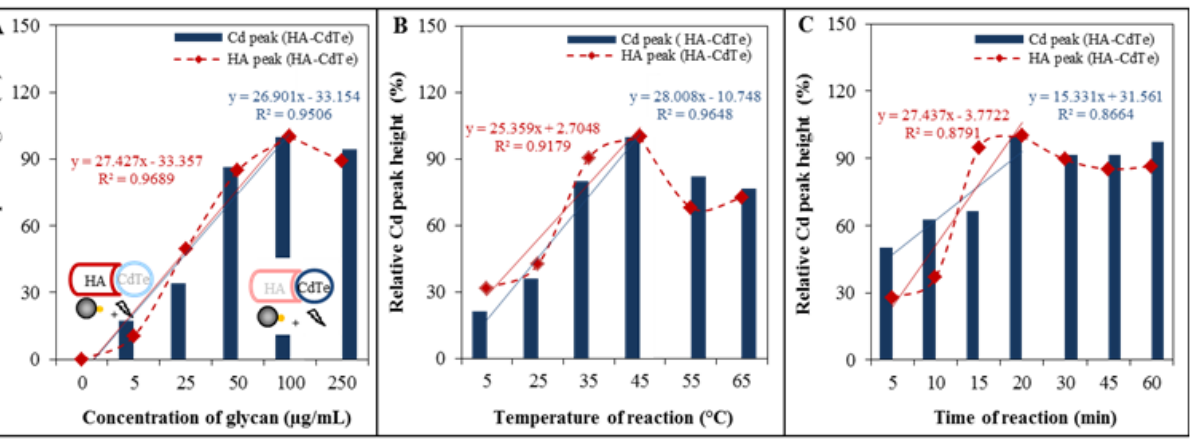
Figure 4. Optimization of isolation procedure. ( A ) Dependence of relative Cd peak height (related to the maximum value) on optimized condition (blue column). Dependence of relative HA peak height (related to the maximum value) on optimized condition (red rhomb). Dependence of relative Cd/HA peak height on concentration of glycan; ( B ) Dependence of relative Cd/HA peak height on temperature of reaction between HA-CdTe and glycan modified MPs; ( C ) Dependence of relative Cd/HA peak height on time of reaction (HA-CdTe and glycan-MPs). Other experimental conditions see in Figure